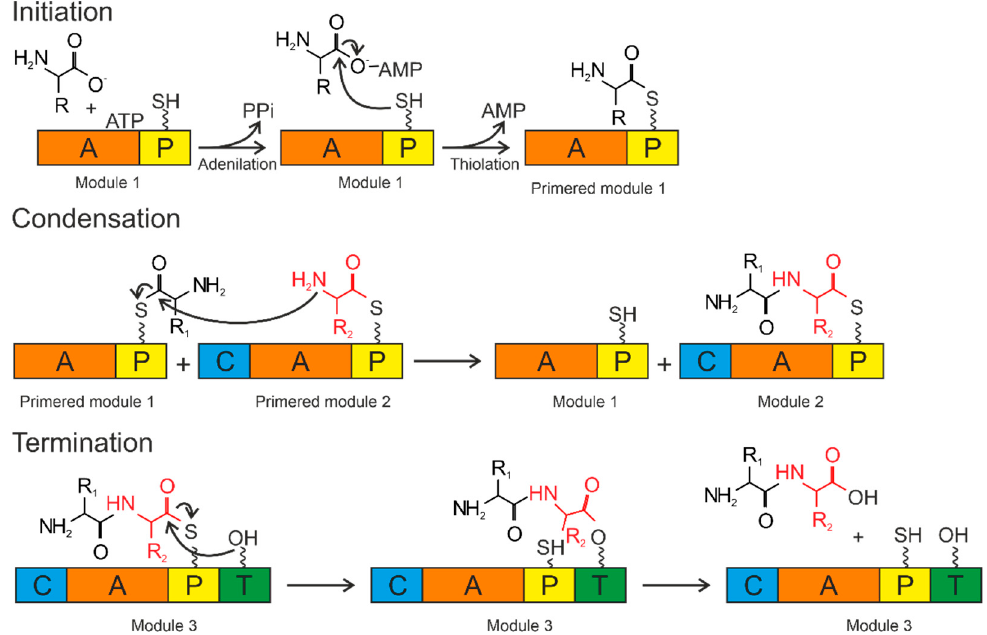
Figure 4. Biosynthesis by NRPS occurs in three steps: initiation, condensation, and termination. The A domain activates the amino acid and attaches it to the P domain (initiation). The condensation reaction occurs between the amino acids bound to the primed modules to form a peptide bond, resulting in the elongation of the peptide. Termination and release of the mature peptide occur by hydrolysis in the thioesterase domain after the product is transferred to the conserved serine residue. Orange—adenylation domain (A); yellow—peptidyl domain (P); blue—condensation domain (C); green—thioesterase domain (T).